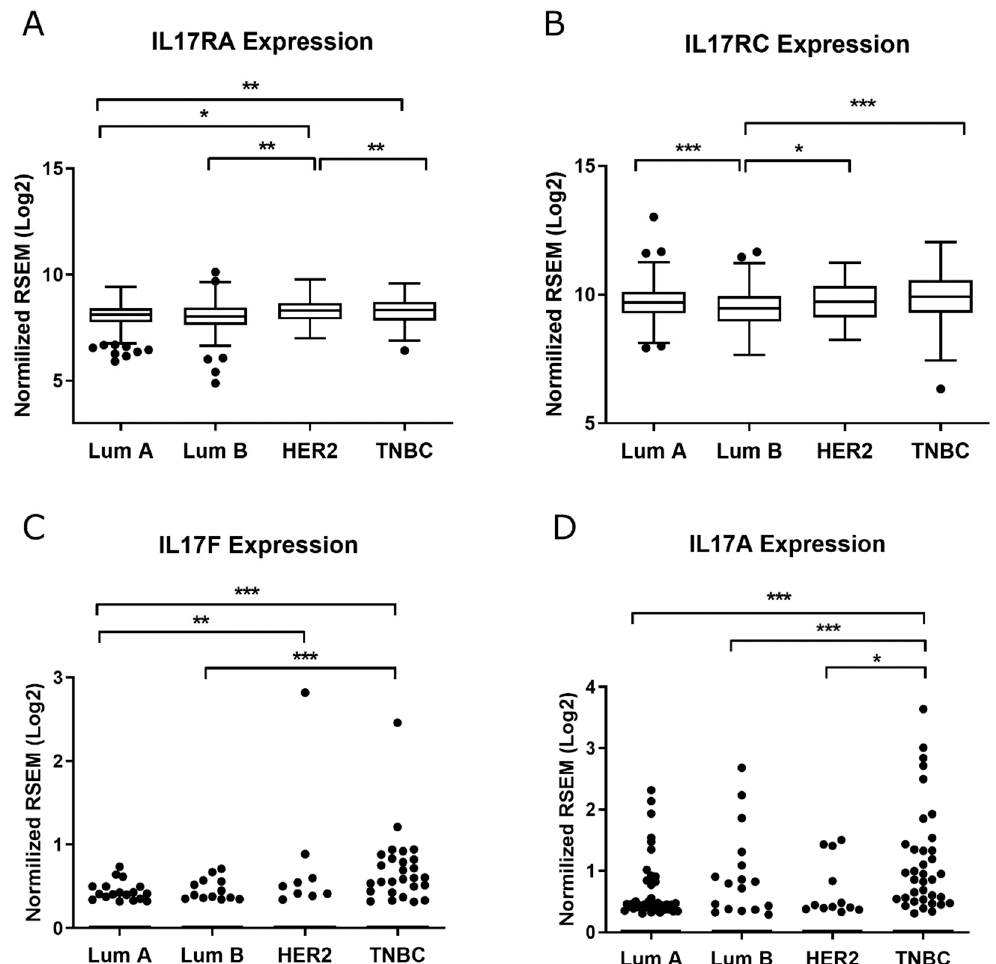
Figure 8. Box-plot graph of IL17RA ( A ), IL17RC ( B ), IL17F ( C ), and IL17A ( D ) expression [RNA-Seq by Expectation-Maximization (RSEM), Log2(Val+1)] in Luminal A, Luminal B, HER2+ and Triple-negative (TNBC) subtypes. Expression values were obtained from TCGA through Linkedomics tools. Data are shown as the median ( ± SD), dots represent outliers. * p < 0.05; ** p < 0.01; *** p < 0.001.